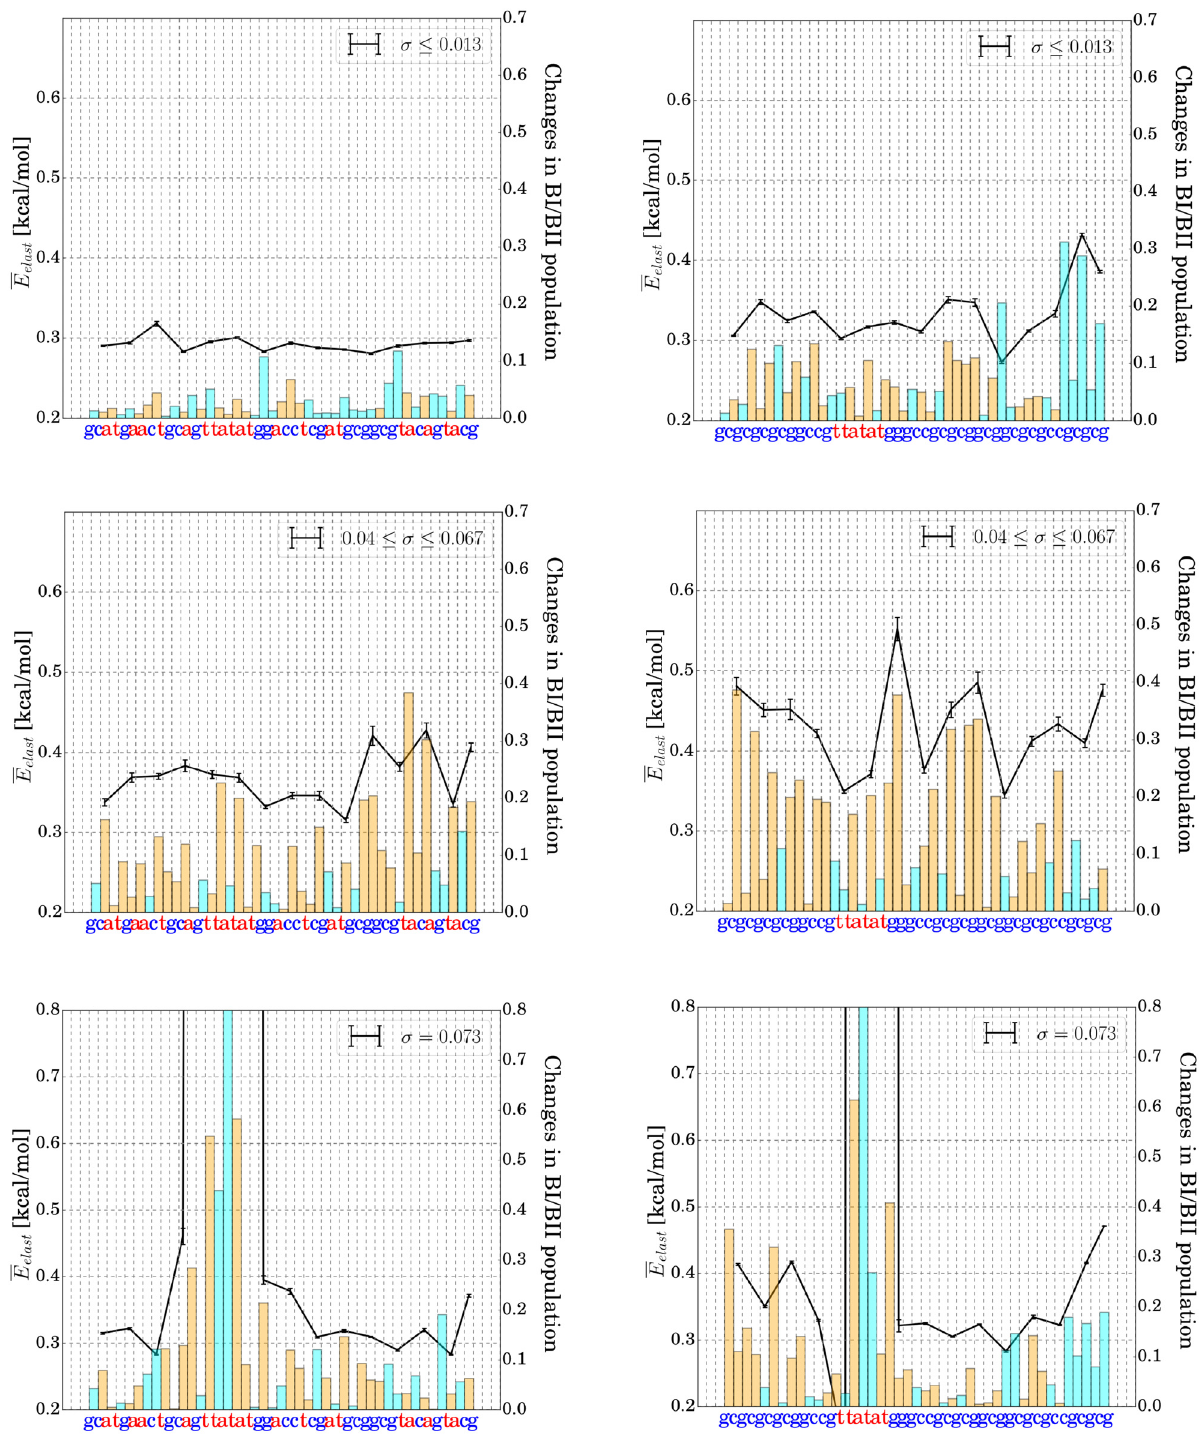
Fig 7. Average elastic energy per degree of freedom and changes in BI/BII conformational substate population with respect to unrestrained simulations for each of the central 43 bp-steps of the heterogeneous at-sequence (left column) and the gc-sequence (right column). Each vertical dashed line in the panels corresponds to a base pair (sequence indicated on the x-axis). The black lines indicate the average deformation energy at each base pair step. The cyan bars indicate an increase in BII, orange bars an average increase in BI states relative to the unrestrained simulation. The profiles have been generated for different levels of global DNA unwinding. Upper panels show simulation results of Umbrella windows with low unwinding. Middle panels illustrate moderate unwinding simulations, where the DNA duplex has still remained structurally intact. Bottom panels